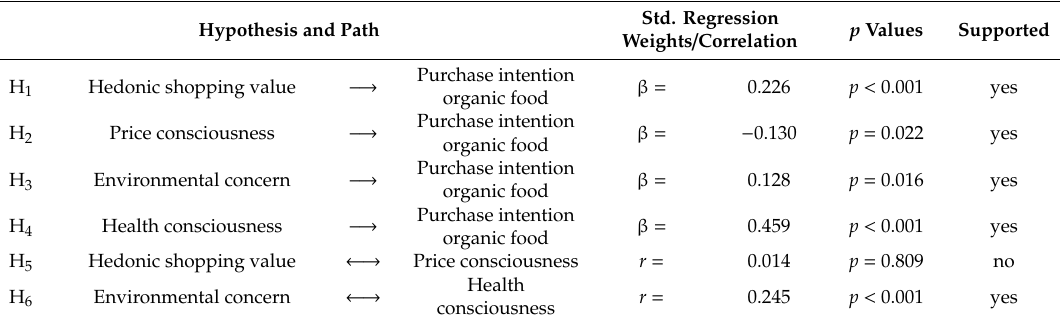
Table 4. Results for the structural